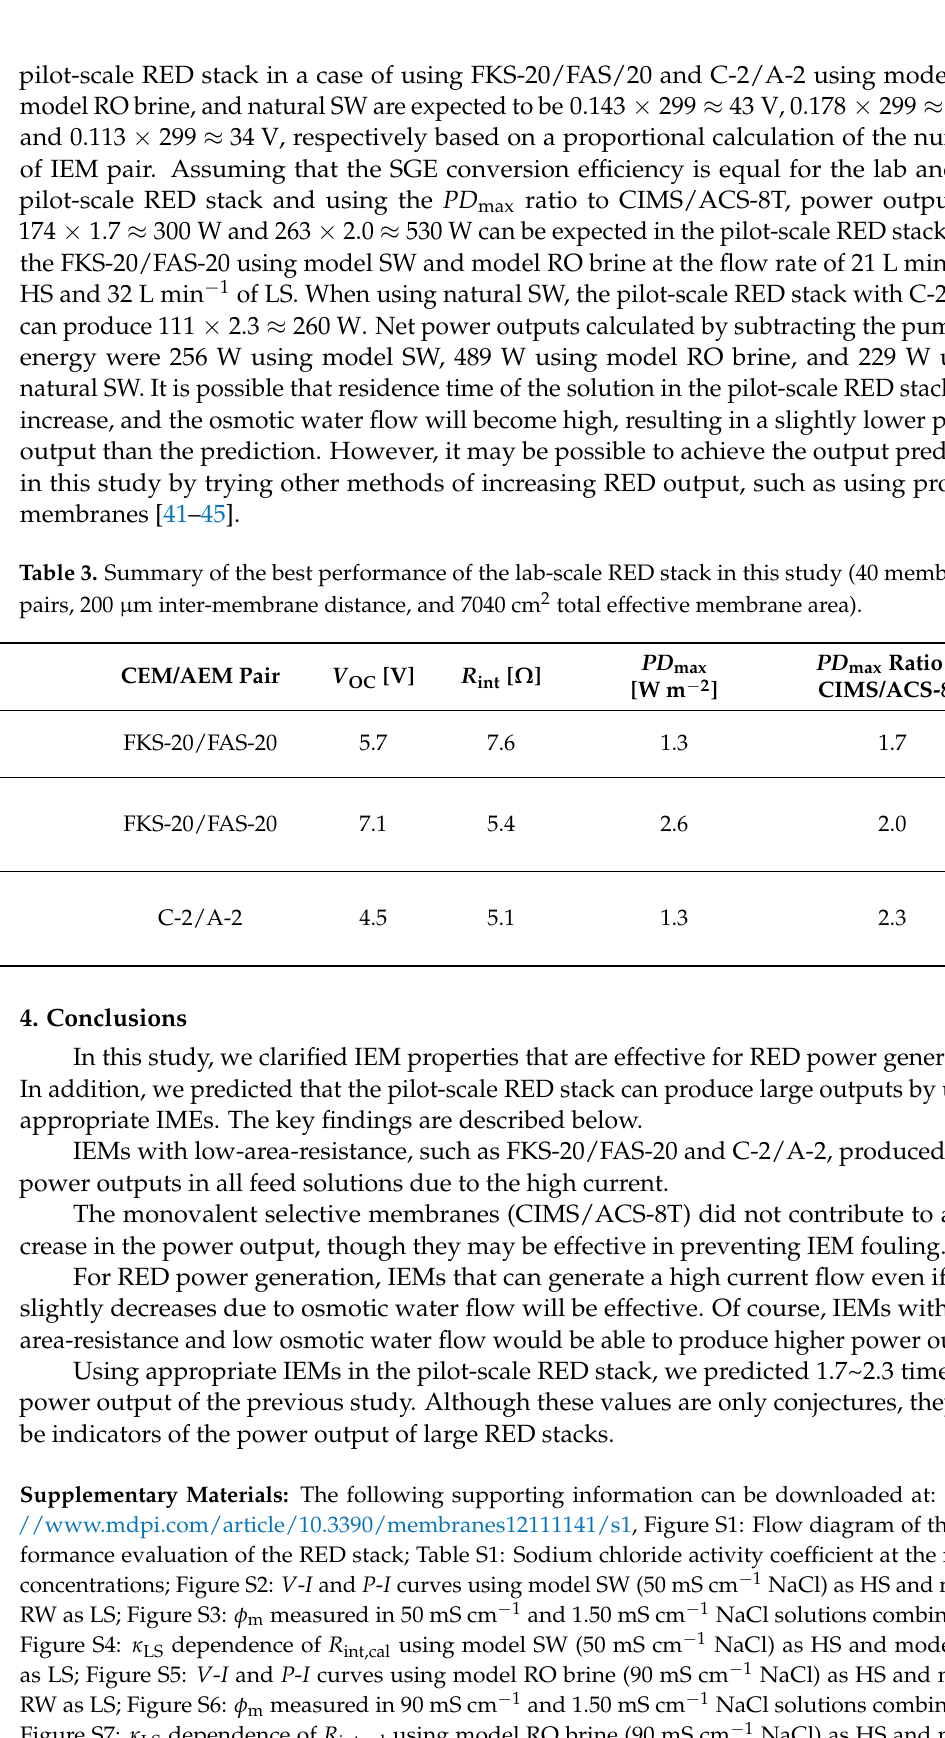
RW as LS; Figure S3: φ m measured in 50 mS cm − 1 and 1.50 mS cm − 1 NaCl solutions combination; Figure S4: κ LS dependence of R int,cal using model SW (50 mS cm − 1 NaCl) as HS and model RW as LS; Figure S5: V - I and P - I curves using model RO brine (90 mS cm − 1 NaCl) as HS and model RW as LS; Figure S6: φ m measured in 90 mS cm − 1 and 1.50 mS cm − 1 NaCl solutions combination; Figure S7: κ LS dependence of R int,cal using model RO brine (90 mS cm − 1 NaCl) as HS and model RW as LS; Figure S8: V - I and P - I curves using natural SW as HS and surface water as LS; Figure